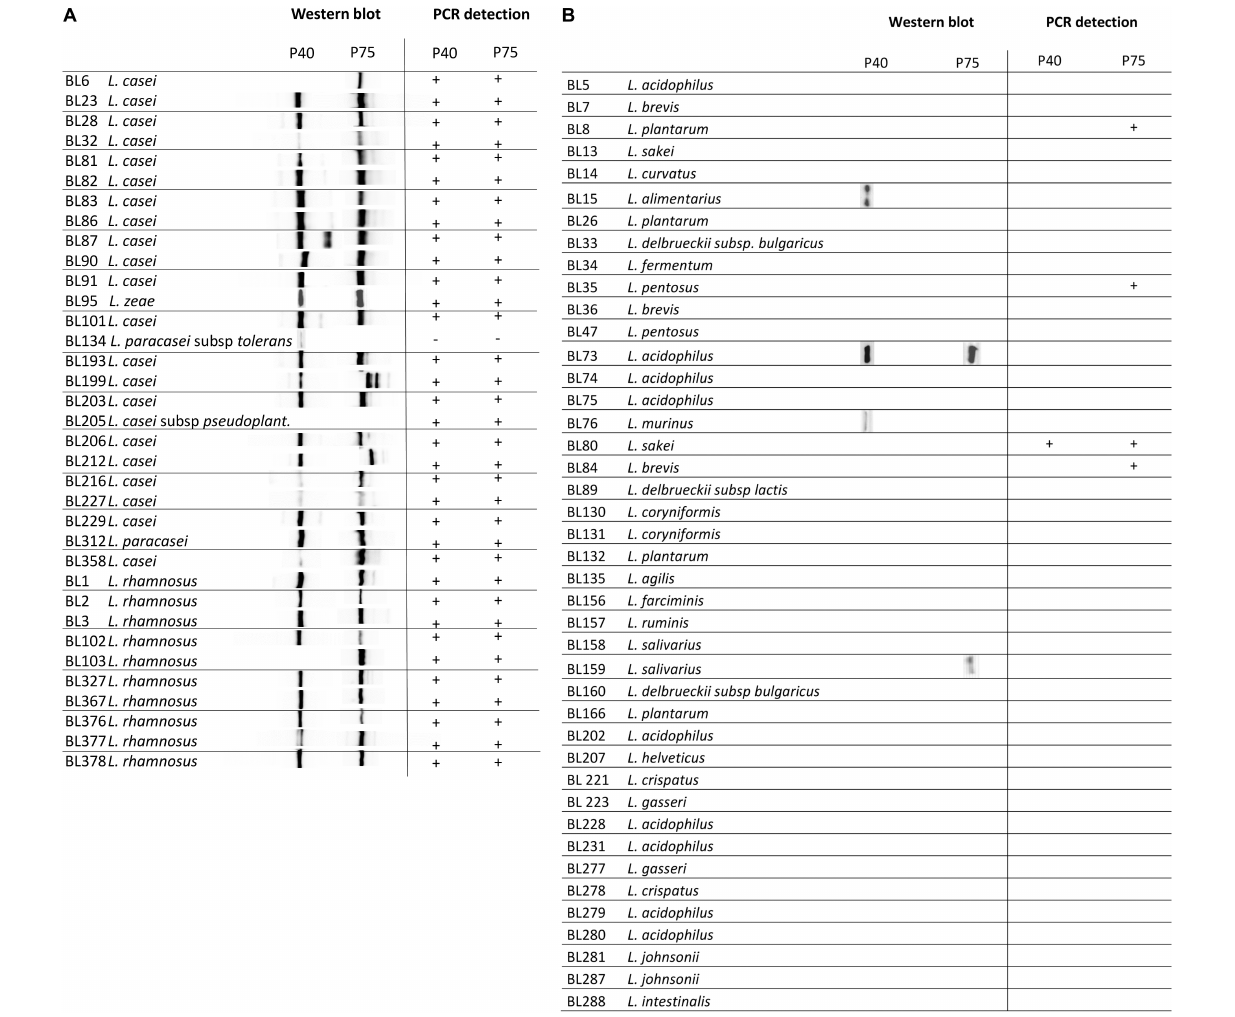
FIGURE 6 | Diagram summarizing immunoblot signals (Western blot) obtained with anti-P40N and anti-P75N from overnight culture supernatants of the designated strains. (A) Shows a group of strains belonging to the taxon Lactobacillus casei/paracasei/rhamnosus and (B) representative strains of the genus Lactobacillus from the laboratory’s